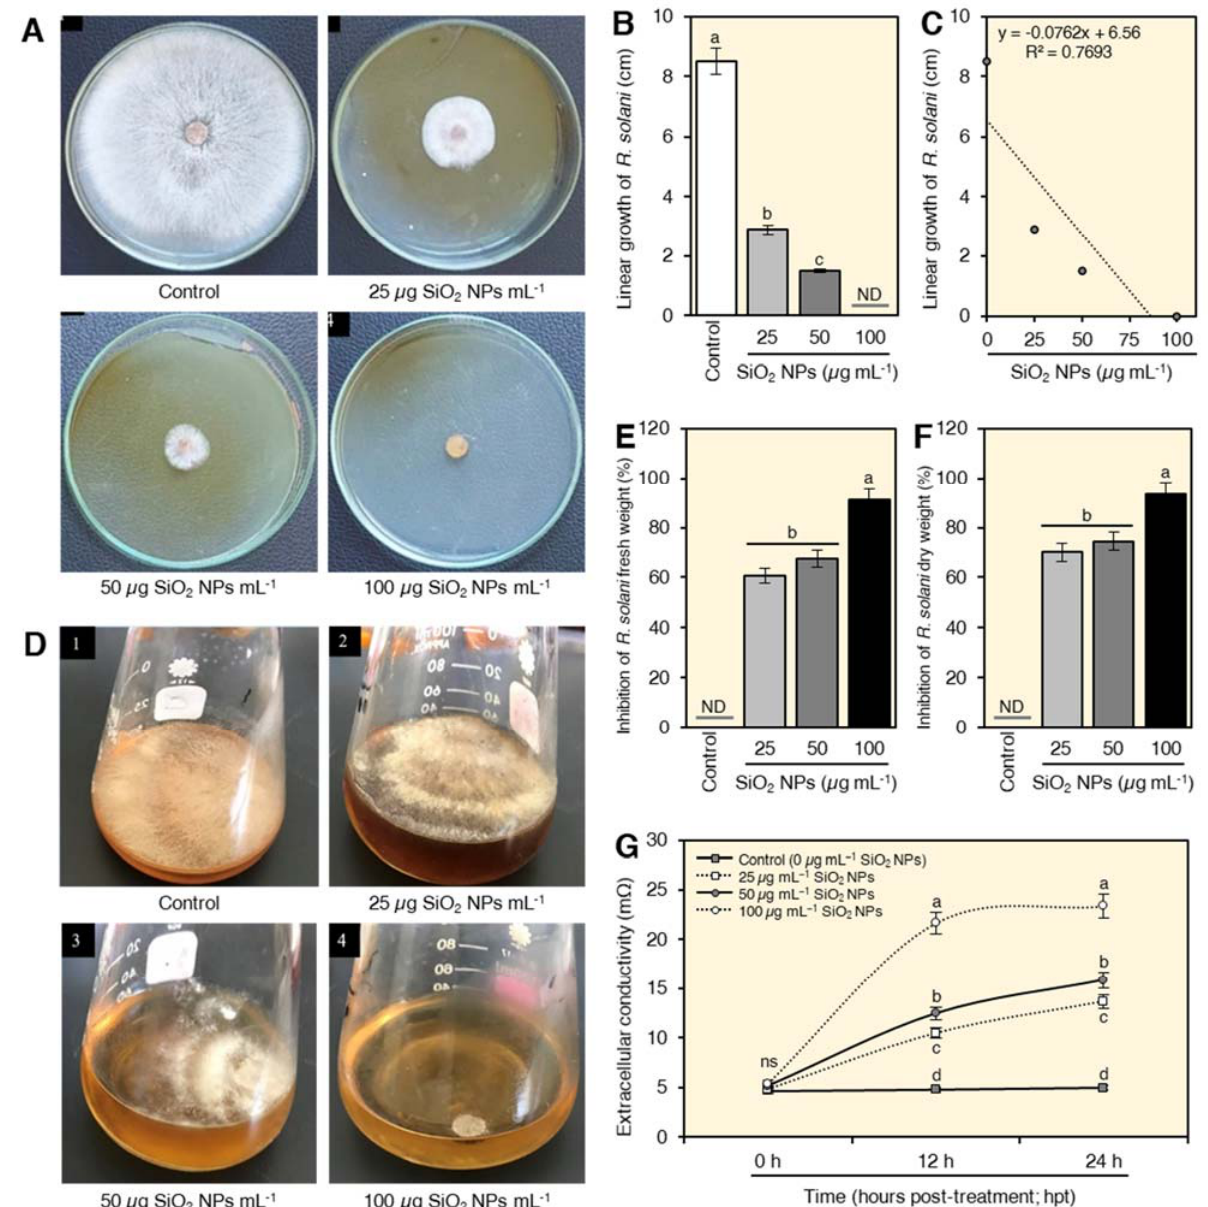
Figure 3. In vitro antifungal activity of silicon dioxide nanoparticles (SiO 2 NPs) against R. solani , the causal agent of wheat damping ‐ off. ( A ) Antifungal activity of different concentrations (0 [control], 25, 50, and 100 μ g mL − 1 ) of SiO 2 NPs against R. solani growing on PDA medium in Petri dishes. ( B ) Linear growth (cm) of R. solani after the treatment with different concentrations of SiO 2 NPs. ( C ) Simple linear regression between linear growth (cm) of R. solani and different concentrations of SiO 2 NPs (0, 25, 50, and 100 μ g mL − 1 ). ( D ) Antifungal activity of different concentrations (0 [control], 25, 50, and 100 μ g mL − 1 ) of SiO 2 NPs against R. solani growing on liquid medium. ( E , F ) Inhibition (%) of R. solani fresh and dry weight, respectively, after the treatment with different concentrations of SiO 2 NPs. ( G ) Effect of different concentrations of SiO 2 NPs on the extracellular conductivity of R. solani suspension at 0, 12, and 24 h post ‐ treatment (hpt). The experiments were repeated twice independently. In bar graphs, data presented are means ± standard deviation (mean ± SD) of five biological replicates. Different letters indicate statistically significant differences among treatments, while the same letters signify no significant differences between them according to Tukey’s honestly significant difference test ( p < 0.05). In simple linear regression graphs, the linear fit regression line is presented as a dotted line, regression equation and R 2 are also presented within the graph.